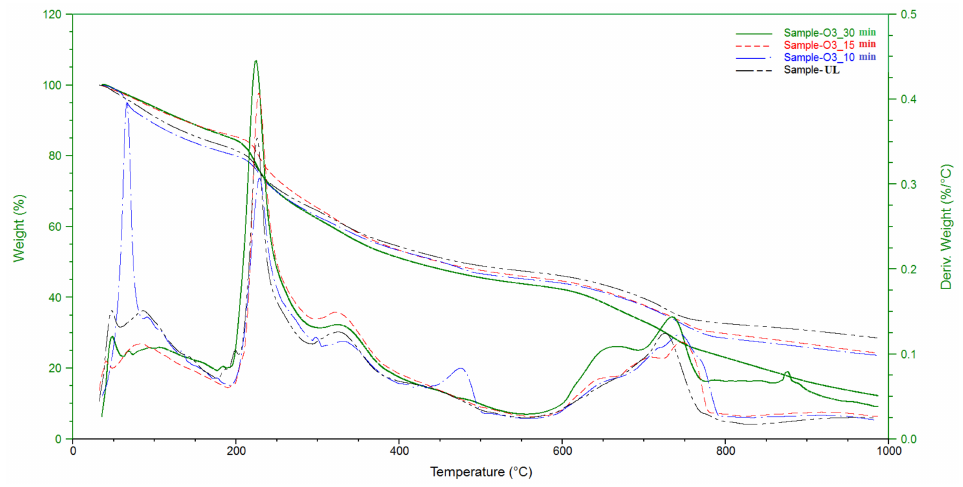
Figure 2. Thermal Analysis (TGA) and Differential thermal analysis (DTA) thermographs of raw and ozonated pretreated Ulva lactuca .